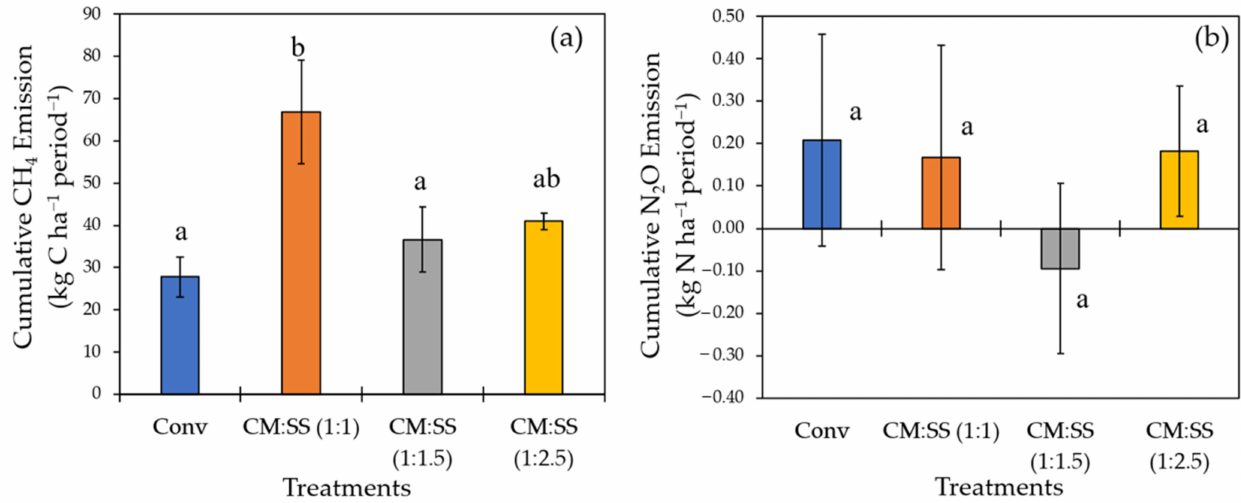
Figure 4. Cumulative CH 4 ( a ) and N 2 O ( b ) emissions in each treatment during the pot experiment. All values are expressed as mean. Conv: conventional, CM: chicken manure, SS: steel slag. Error bars represent standard error. Different letters among the treatments indicate a significant difference ( p <